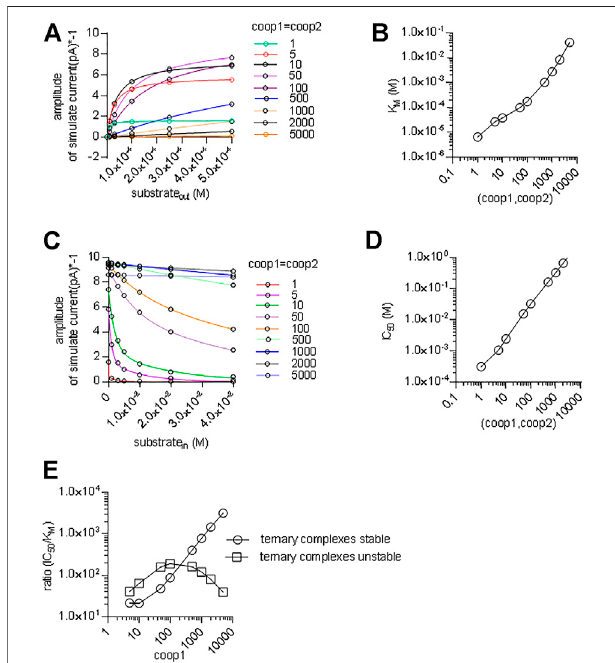
FIGURE 8 | A cooperative model allowing for unstable ternary complex fails to support large enough a difference in the apparent substrate af fi nity for the outward and inward facing conformation. (A) The reaction scheme illustrated in Figure 7A was used to generate the synthetic concentration-responsecurvesforcurrentselicitedbyexternalcreatine.Inthe simulations, coop1 and coop2 were assumed to be equal and allowed to vary from 1 to 5,000 (as indicated in the caption). The solid lines were drawn by fi tting the data points to the equation for a rectangular hyperbola. (B) The K valuesforsubstratewereextractedfromthecurve fi ttingshowninpanelAand plotted as a function of the corresponding value of coop1 & coop2. (C) Inhibition of the steady current amplitude as a function of the intracellular concentration ofcreatine. The differently coloredcurvesshowthe resultsfrom simulationsinwhichcoop1andcoop2wereassumedtobeequalandallowed to vary from 1 to 5,000 (as indicated in the caption). (D) The IC 50 values for internal substrate were extracted from the curve fi tting shown in panel C and plottedasafunctionofthecorrespondingvalueofcoop1&coop2. (E) Plotted in the graph are the ratios (IC 50 /K M ) from the data in panels B and D (open squares) and from Figures 7E,G (open circles) as a function of the coop 1 values used in the corresponding simulations, where coop 2 = coop1 and hence ternary complexes are unstable (open squares) or coop 2 = 1 and hence ternary complexes are stable (open